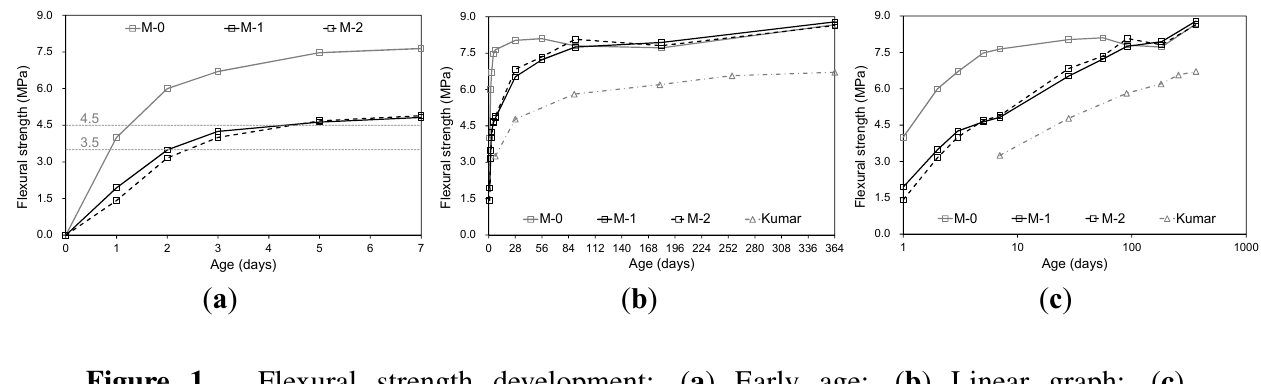
Figure 1. Flexural strength development; ( a ) Early age; ( b ) Linear graph; ( c ) Semi-logarithmic graph.